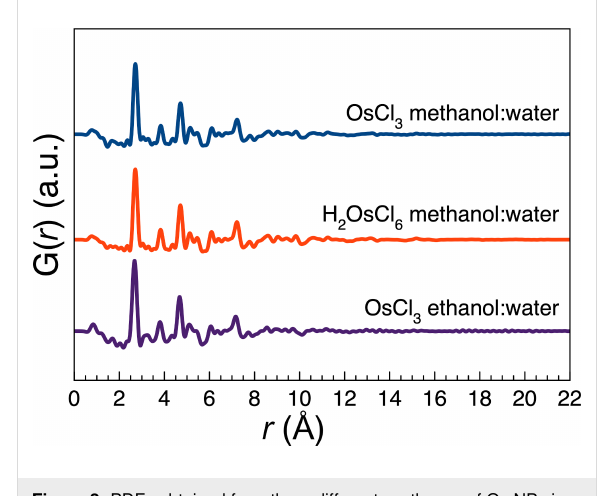
Figure 2: PDFs obtained from three different syntheses of Os NPs in 1:2 alcohol/water ratios and for different precursors as indicated. The PDFs can be described using a hcp